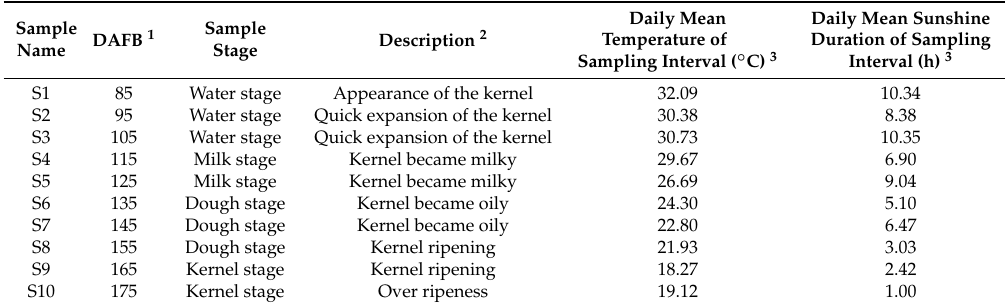
Table 3. Sample list and